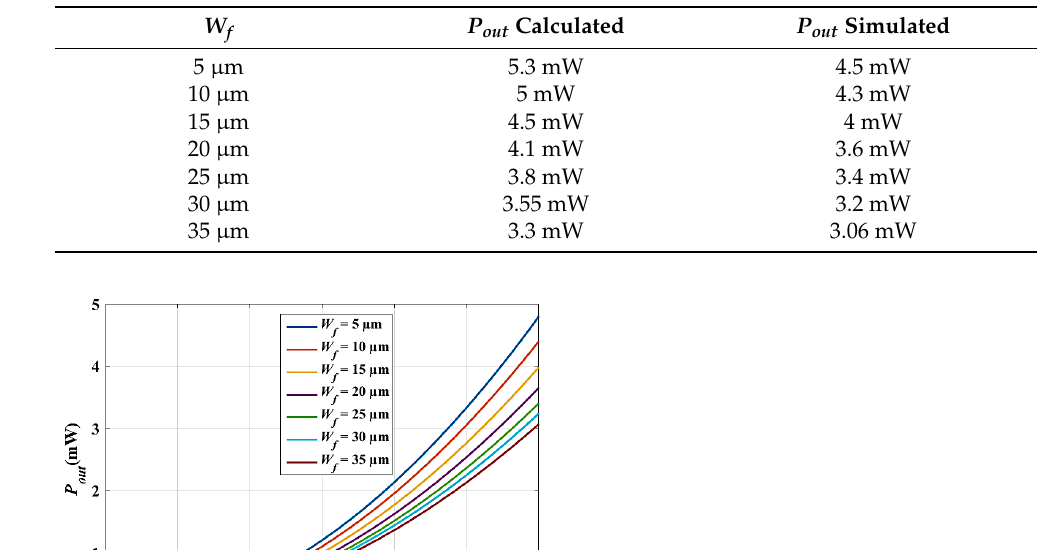
Table 2. P out at different W f .